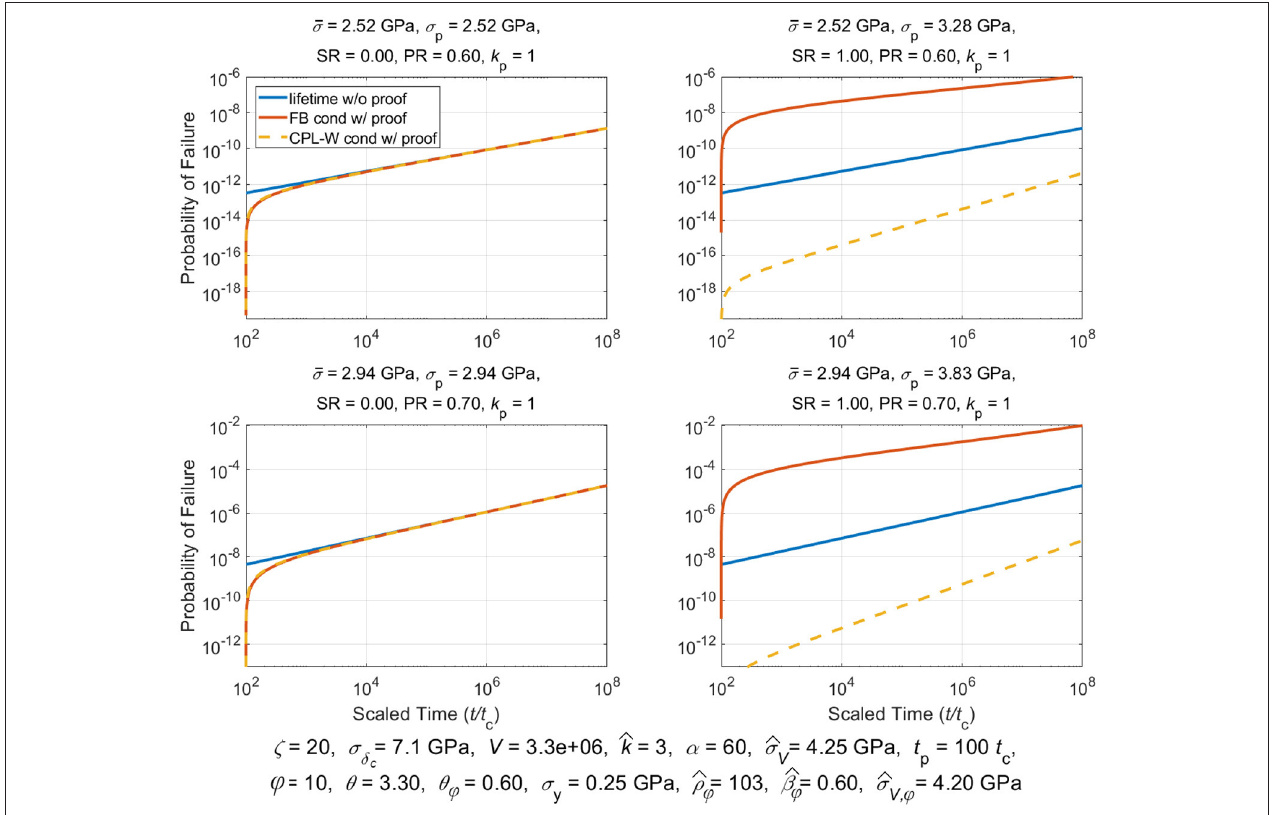
FIGURE 7 | COPV lifetime distribution where tows are modeled as being arranged in a planar array, and with matrix parameter ϕ